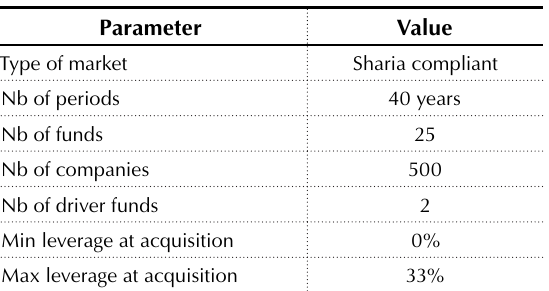
Table 2. Model assumptions [Islamic market case]